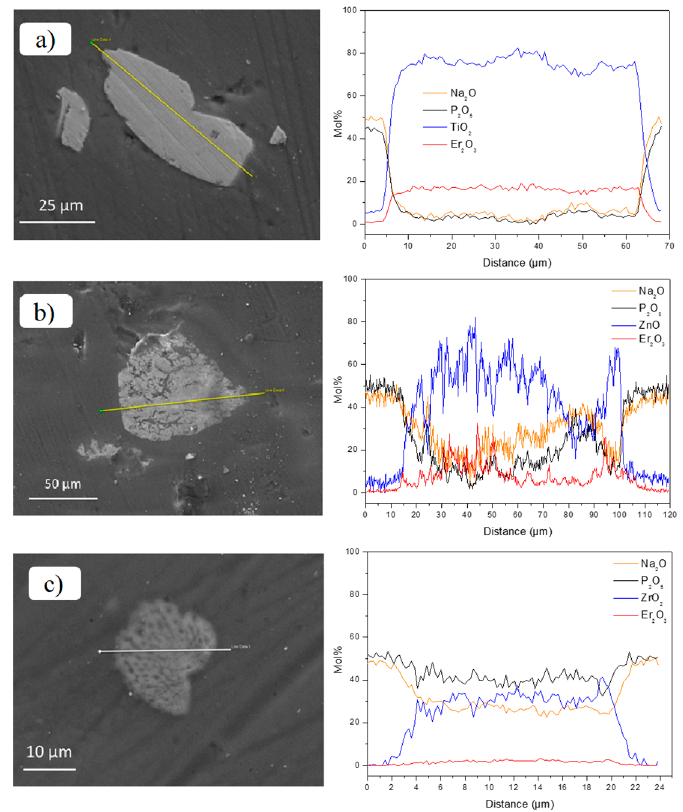
Figure 8. FE-SEM pictures with their corresponding elemental mapping of Er 2 O 3 -doped TiO 2 ( a ), ZnO ( b ), and ZrO 2 ( c ) particles-containing NaPF10 glasses. The direction of the scan starts at the circle of the white line (corresponding to 0 µm).